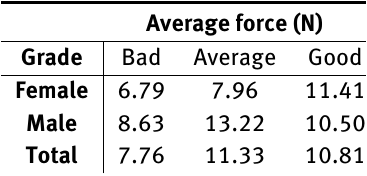
Table 1: Average sum of sensor forces by user feedback.